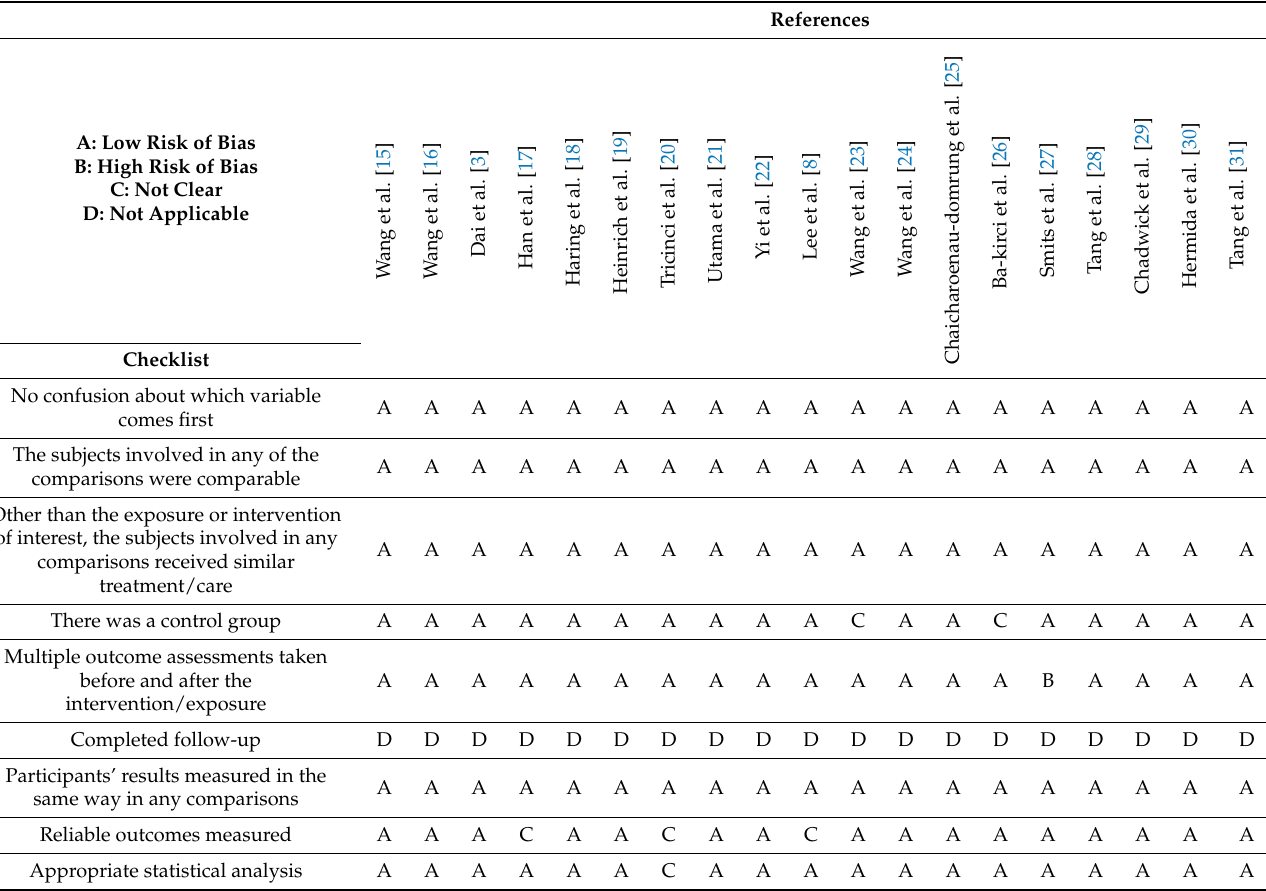
Table 1. Risk of bias assessment of the included studies.